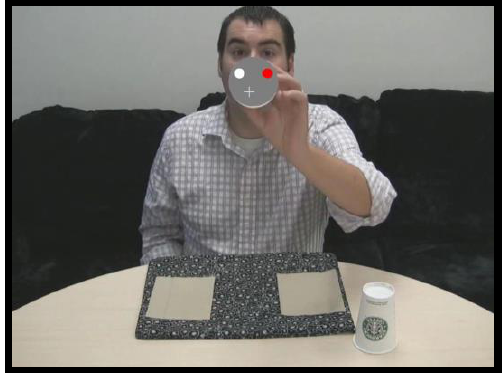
Figure 2. Screen shot depicting the fixation target present for participants in the constrained viewing